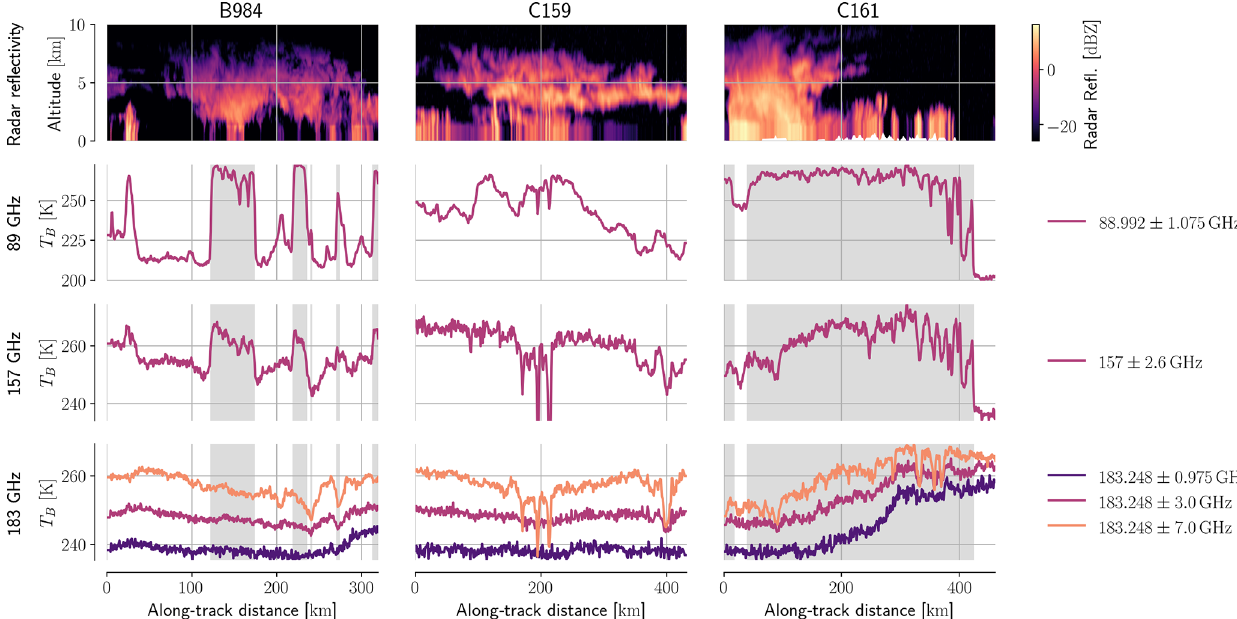
Figure 4. Passive microwave measurements from the MARSS radiometer together with the matched radar observations. Grey background in the radiance plots marks observations that were taken over land. Table 2. Retrieval quantities and a priori assumptions used in the retrieval. The relation for the a priori mean of log 10 (N ∗ Cazenave et al.